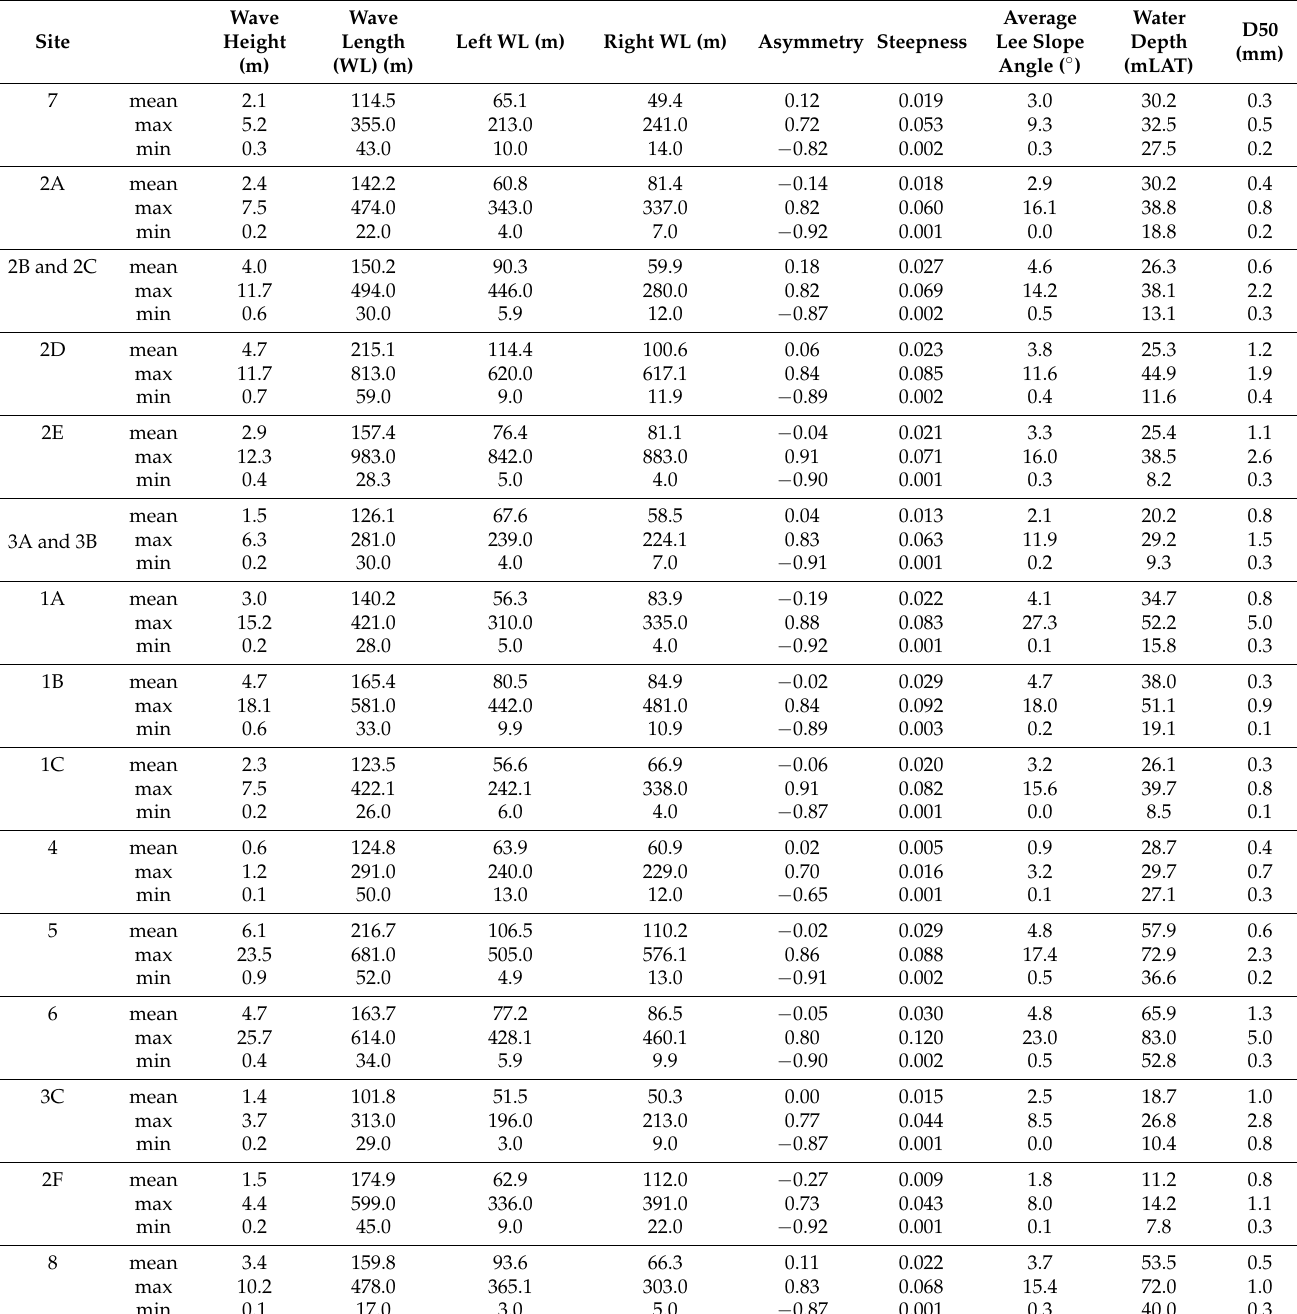
Table 4. Sediment wave characteristics for each individual study site based on first time-lapse bathymetric